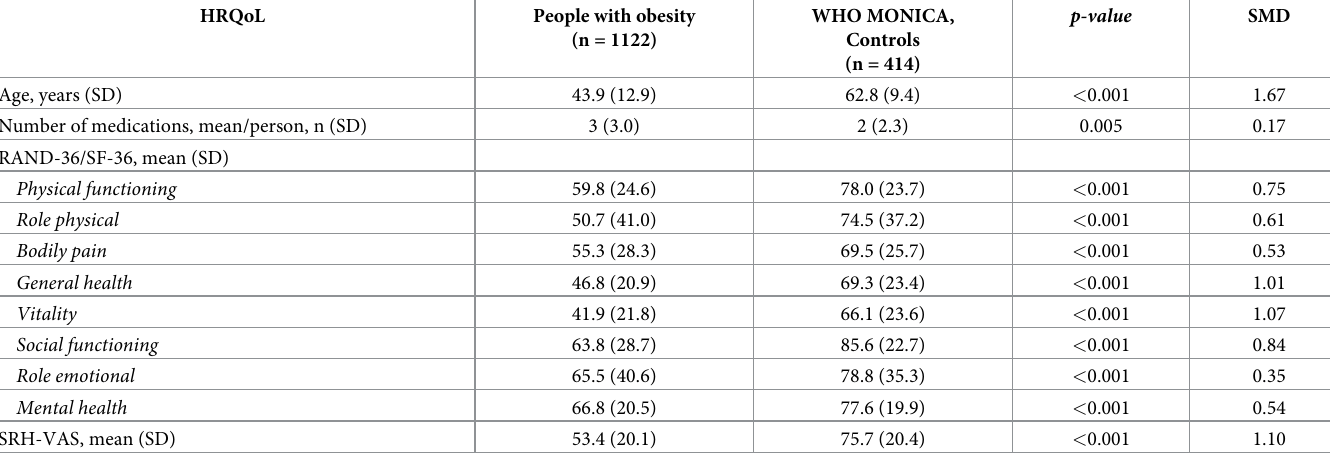
Table 2. Health-related quality of life (HRQoL) measured with RAND-36/Short Form-36 (SF-36) and SRH-VAS in people with obesity (BASUN) and a reference population from the WHO-MONICA study, Gothenburg, Sweden. Mean values are given for all subscales. HRQoL People with obesity WHO MONICA, (n = 1122) Controls